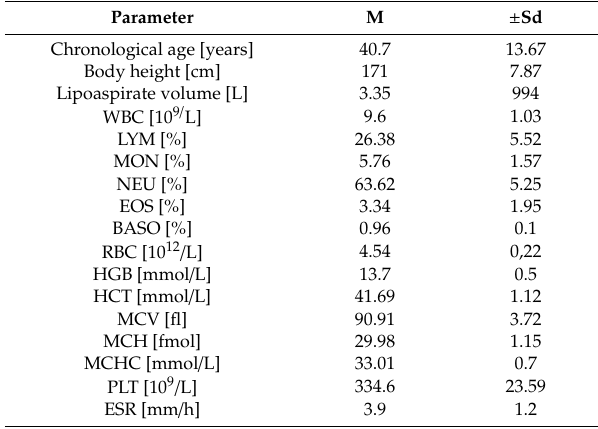
Table 2. Anthropometric characteristics of the patients before and 3 months after liposuction surgery.